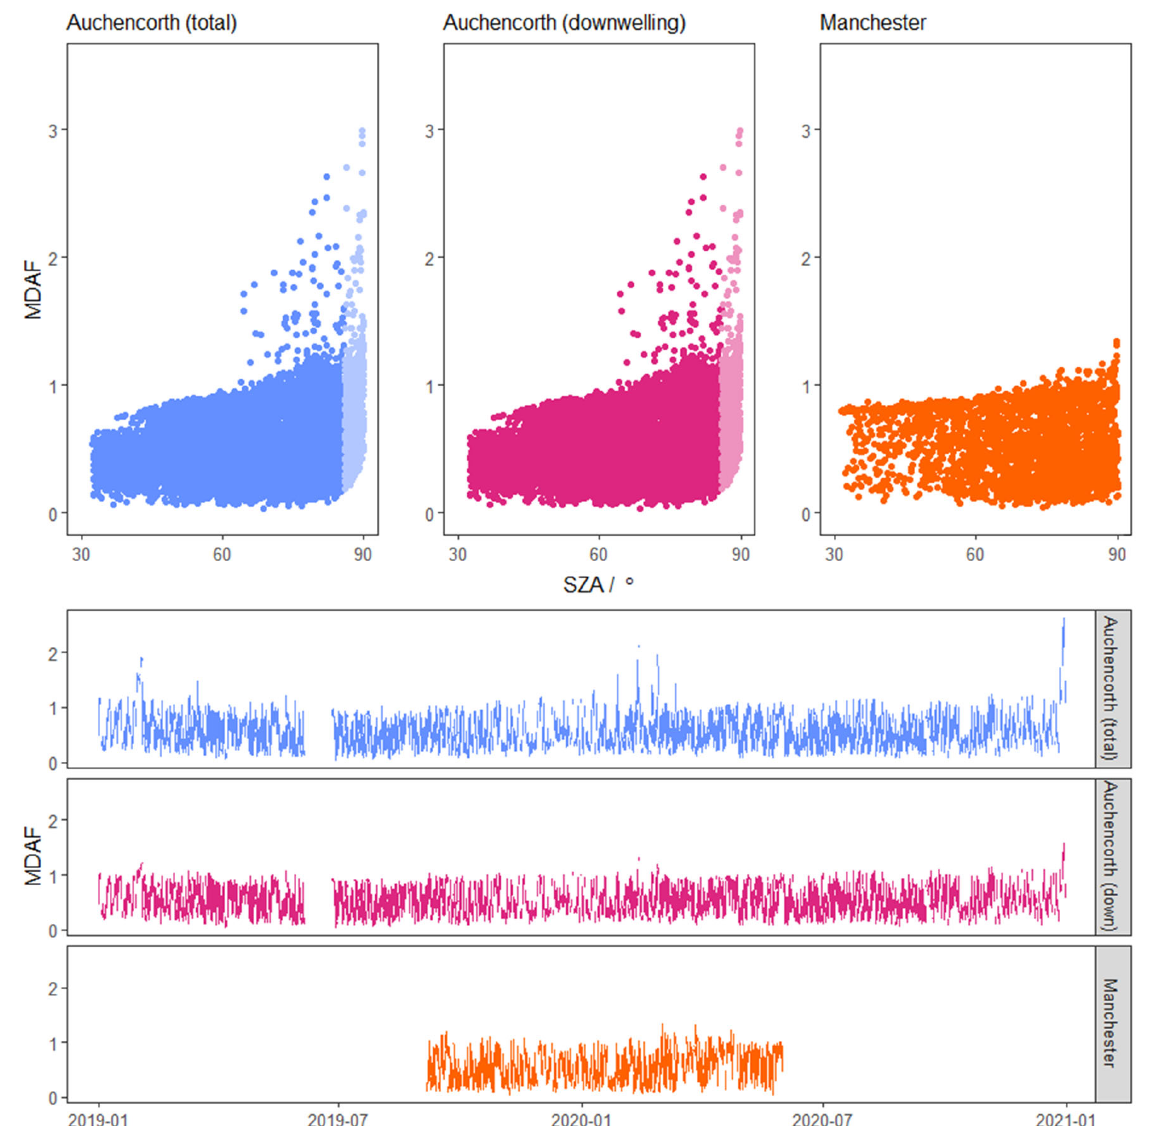
Figure 4. Hourly derived measurement driven adjustment factors (MDAF) for j (NO 2 ) at Auchencorth Moss (blue: total; pink: downwelling) and Manchester (orange). Top: MDAF values as a function of SZA. Bottom: time series of all hourly MDAF values. Auchencorth Moss filter radiometer measurements of higher uncertainty (>85 ◦ ) have been filtered out of the time series, but are presented on the scatter plots in a lighter colour.